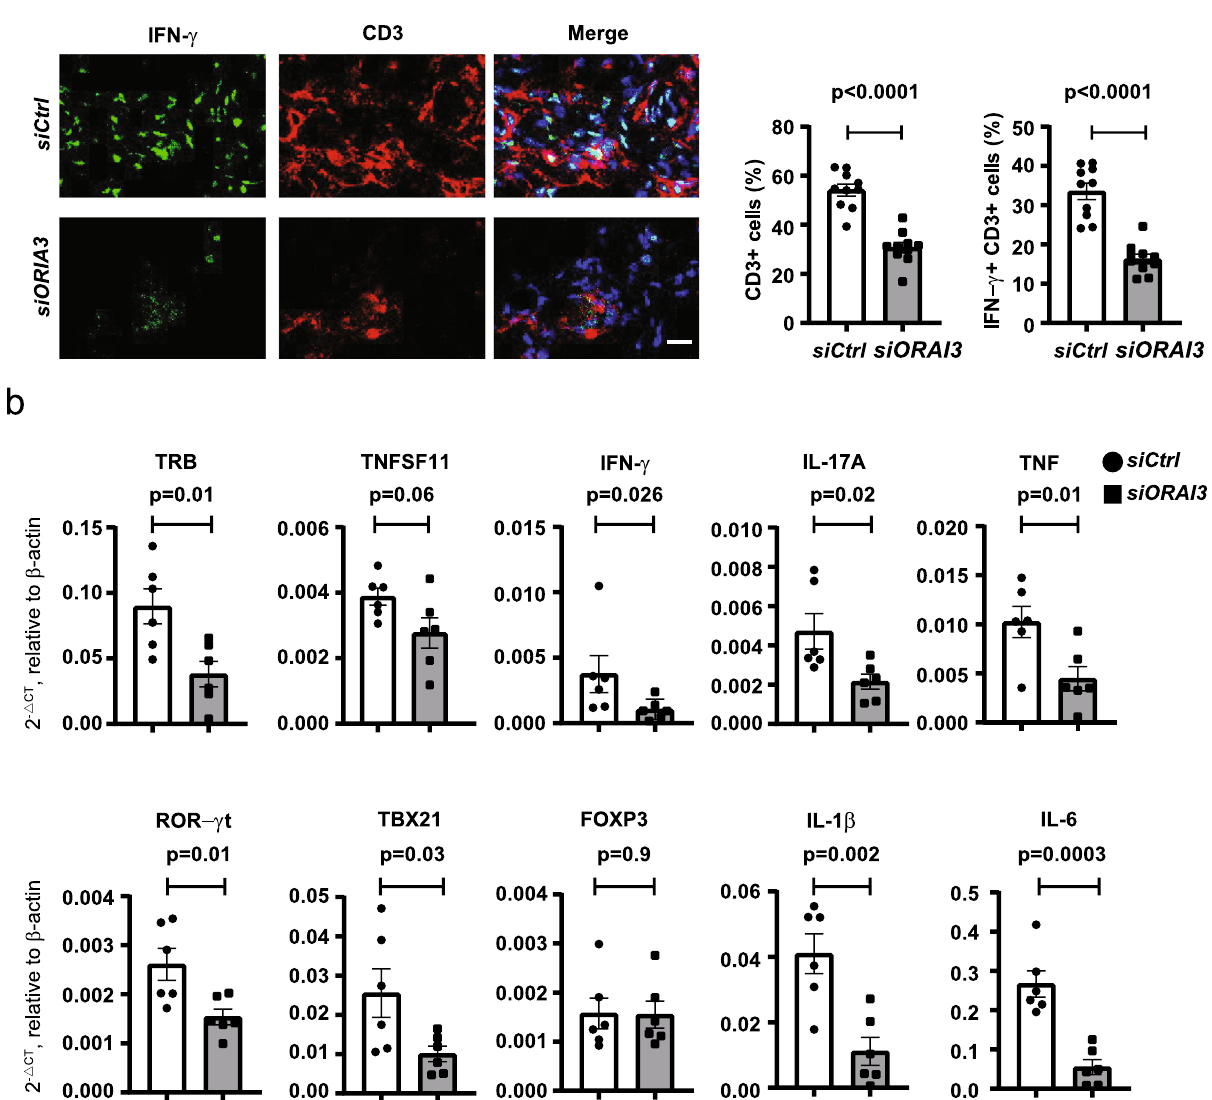
Fig. 6 Silencing of ORAI3 in RA T cells reduces synovial in fl ammation. a , b NSG mice engrafted with human synovial tissue were reconstituted with CD45RO – PBMC from RA patients transfected with control or ORAI3 siRNA. Tissue was collected on day 7 after reconstitution and analyzed. a Three-color immuno fl uorescence staining of tissue sections for IFN- γ and CD3 (left). Scale bars, 20 µ m. Frequencies of CD3 + and IFN- γ + CD3 + T cells in synovial tissues are shown as mean ±SEM of ten random fi elds of six synovial grafts for each treatment arm (right). Data were analyzed with unpaired two-tailed Student ’ s t test. b Expression of genes encoding lineage-determining transcription factors and key in fl ammatory markers as determined by RT-PCR. Results from tissues of mice ( n = 6) adoptively transferred with control cells are shown as white bars and circles, and those from mice with ORAI3-silenced cells as gray bars and squares. Data are presented as mean± SEM and analyzed with unpaired two-tailed Student ’ s t test. Source data are provided as a Source Data fi are given in Supplementary Table 1. RA and PsA patients were predominantly male re fl ecting the gender distribution at the Palo Alto Veterans Administration TCR signaling pathway and may, therefore, be involved in the Rheumatology Clinic. Healthy individuals did not have a personal or family history loss of tolerance. Interventions preventing the downregulation of of autoimmune diseases and no history of cancer. Chronic diseases such as IKAROS might decrease the risk of developing RA or prevent the hypertension or diabetes mellitus were included as long as controlled on oral ampli fi cation of the disease process. Alternatively, inhibition of medication. The protocol was approved by the Stanford University Institutional AA production, generated by PLA2 62 or by PLC and DAG lipase, Review Board, and all participants gave written, informed consent. may reduce ARC channel activity and be protective. Methods Study populations . Peripheral blood was obtained from 97 patients with RA, 15 patients with PsA, 6 patients with gout, 7 patients with SLE and 119 HCs. RA patients ful fi lled the ACR diagnostic criteria for RA and were positive for rheu- matoid factor and/or anti-citrullinated protein Abs. Demographic and clinical data